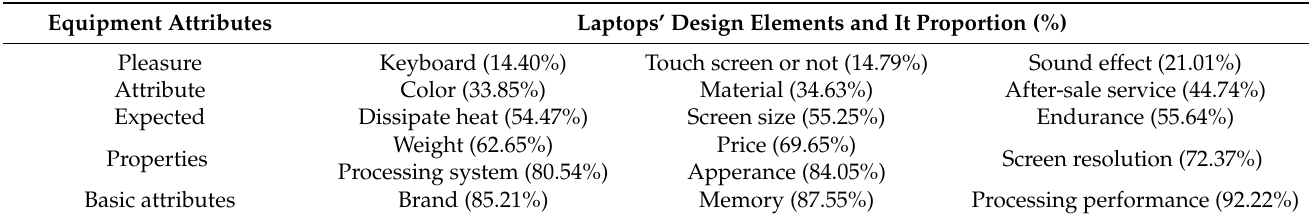
Table 1. Design elements–user demands classification.